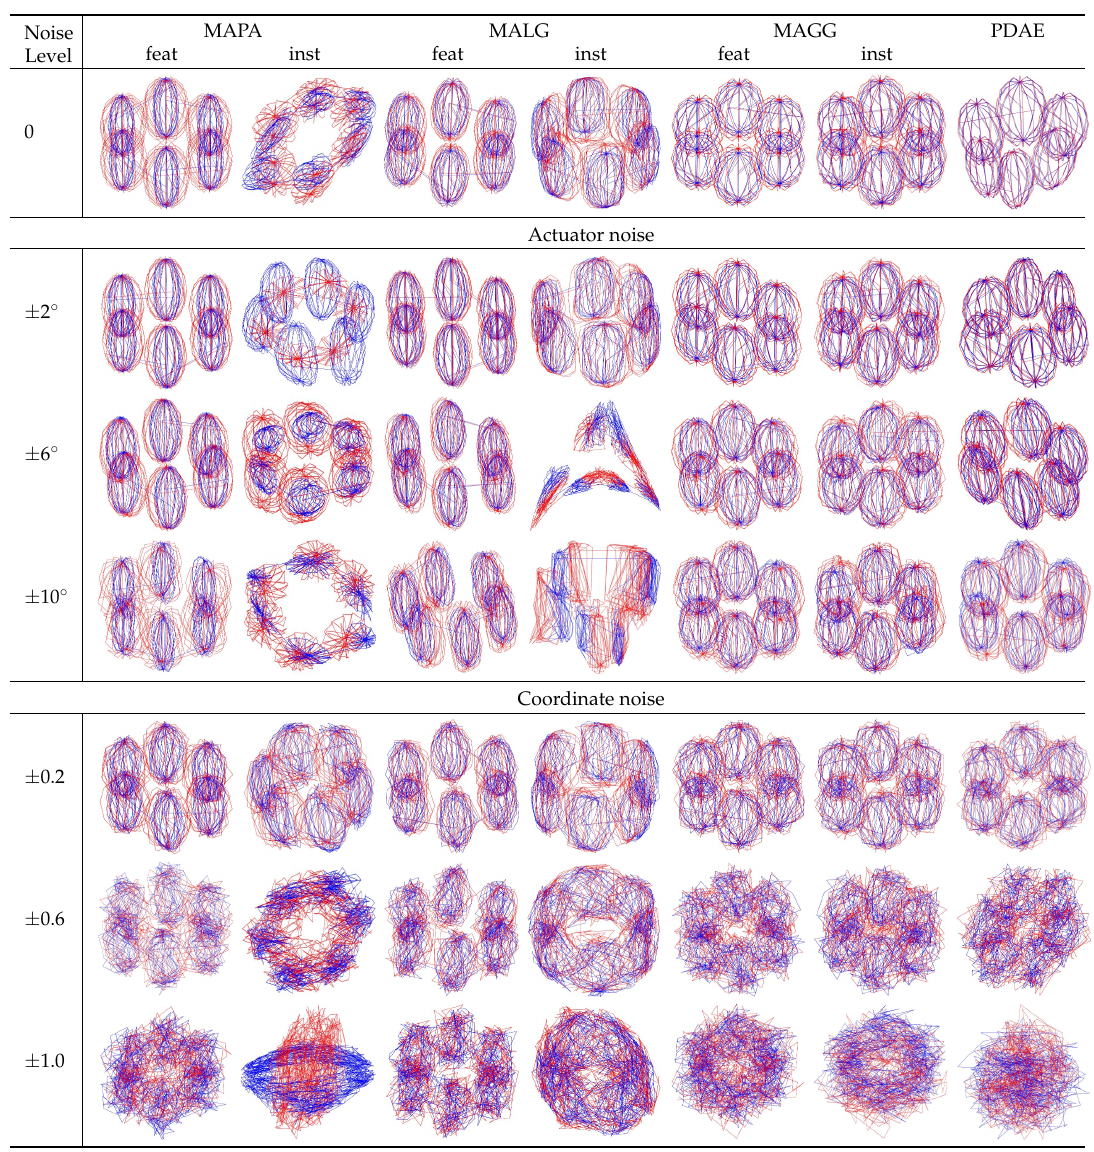
Figure 6. Manifold alignments of 2D-3D motion data under the influence of noise: The graphs visualise the outcomes of aligning datasets X (red) and Y (blue) using the seven methods mentioned at the top. Each row shows the results obtained under the influence of a different level of noise. The expected outcome is S 1 × S 2 , that is a ring of spheres where, for clarity, our visualisations showed a section comprising six spheres S 2 at equally-distributed positions on the circle S 1 . Of all methods tested, the PDAE shows the best performance with almost perfectly-aligned manifolds shown at the right end of the top row. With the addition of noise, the results